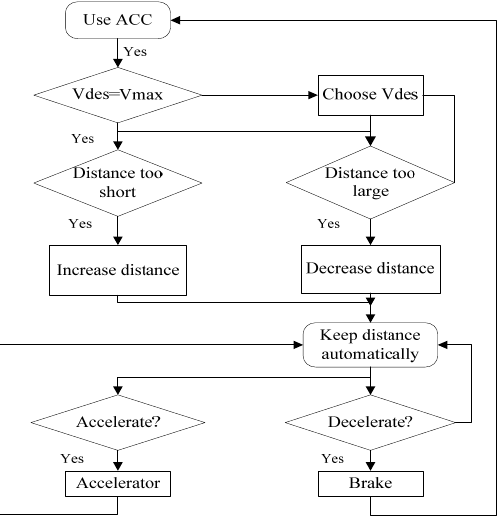
Fig.5. Operation of Adaptive Cruise Control system in traffic system